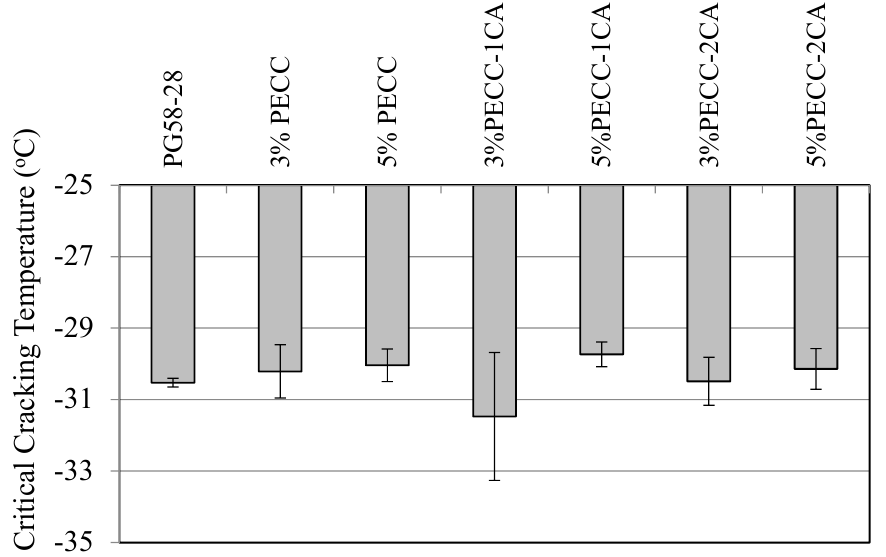
Figure 10. Critical cracking temperature of PECC-based asphalt binders compared to control specimen.